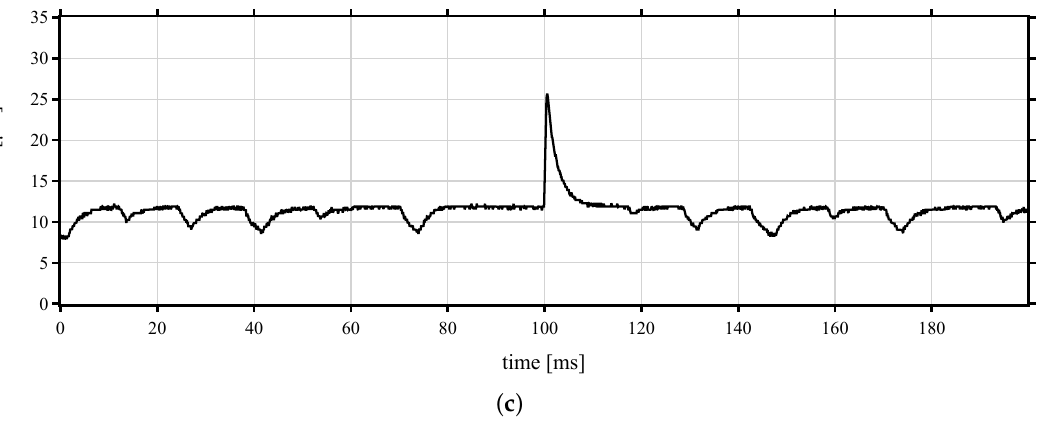
Figure 17. Current curve of WuPt. ( a ) Transmitter node, ( b ) receiver node with BJT, and ( c ) receiver node with TIA